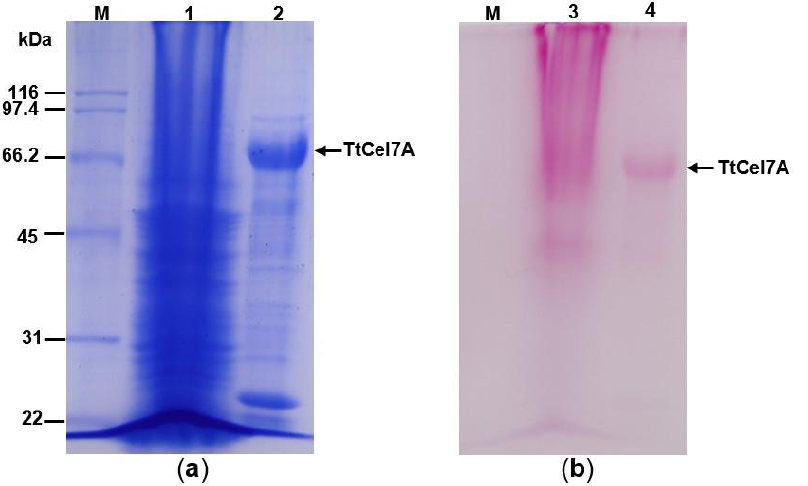
Figure 3. ( a ) A 10% SDS-PAGE analysis of semipurified TtCel7A. ( b ) Glycoprotein analysis, Schiff stained of semipurified TtCel7A. Lanes M: molecular weight standard; 1 and 3: Invertase from Saccharomyces cerevisiae as control; 2 and 4: semipurified TtCel7A.